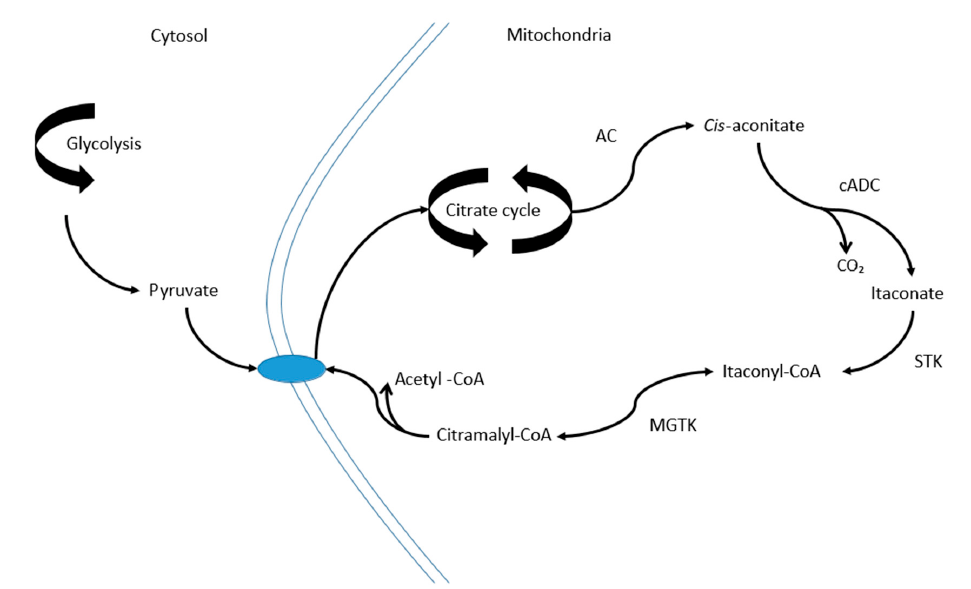
Figure 2. Scatter plots demonstrating change in DAS44 between baseline and 3 months vs. change in log2 peak intensity of 8 putative metabolites. The Itaconate peak (Peak 255) has been identified. Peaks 1072 and 302 have been given putative identities of Itaconate anhydride and Itaconyl-CoA, respectively.